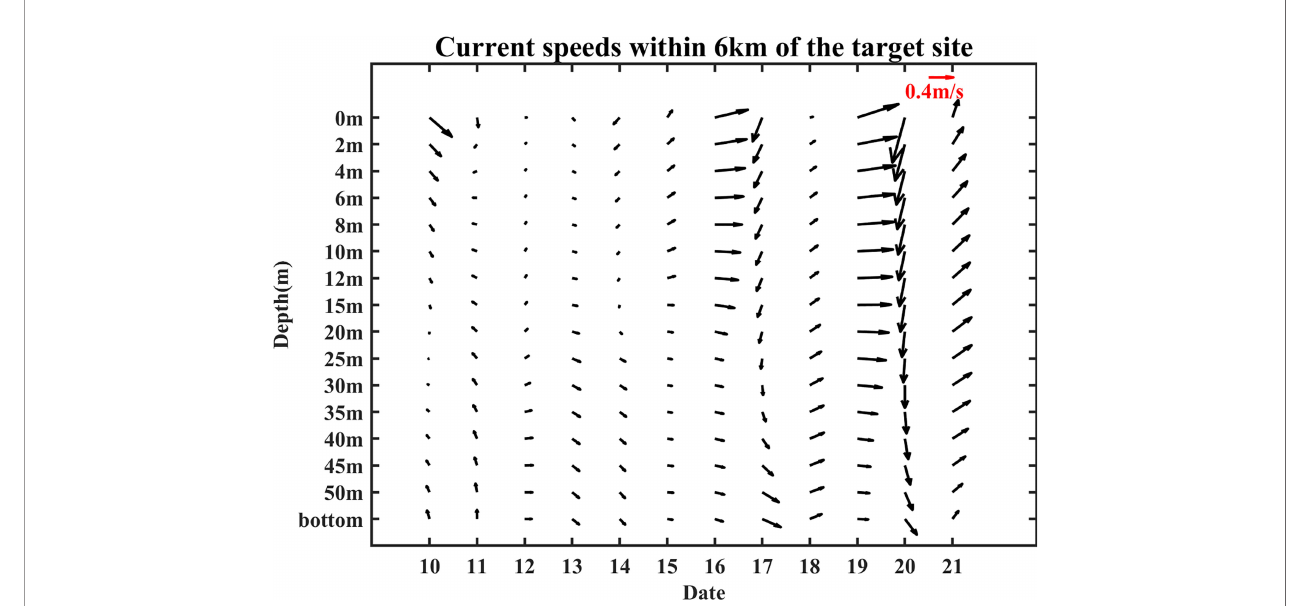
FIGURE 10 | Current speeds of the target site from 10 to 21 February. The data were from